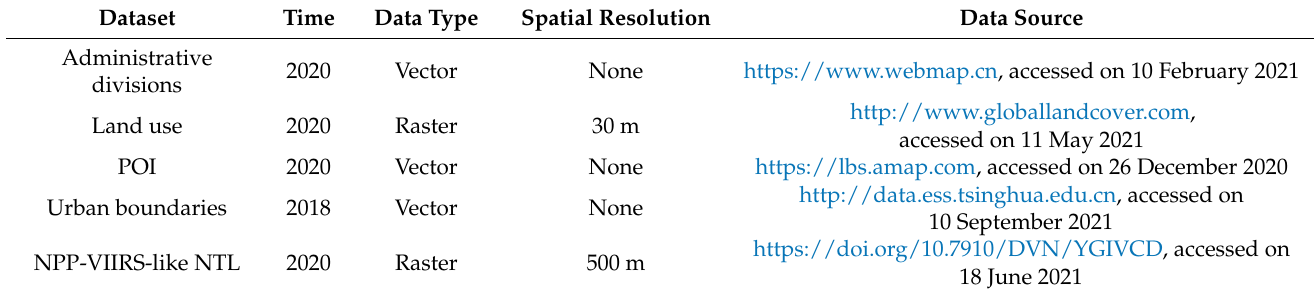
Table 1. Datasets used in the